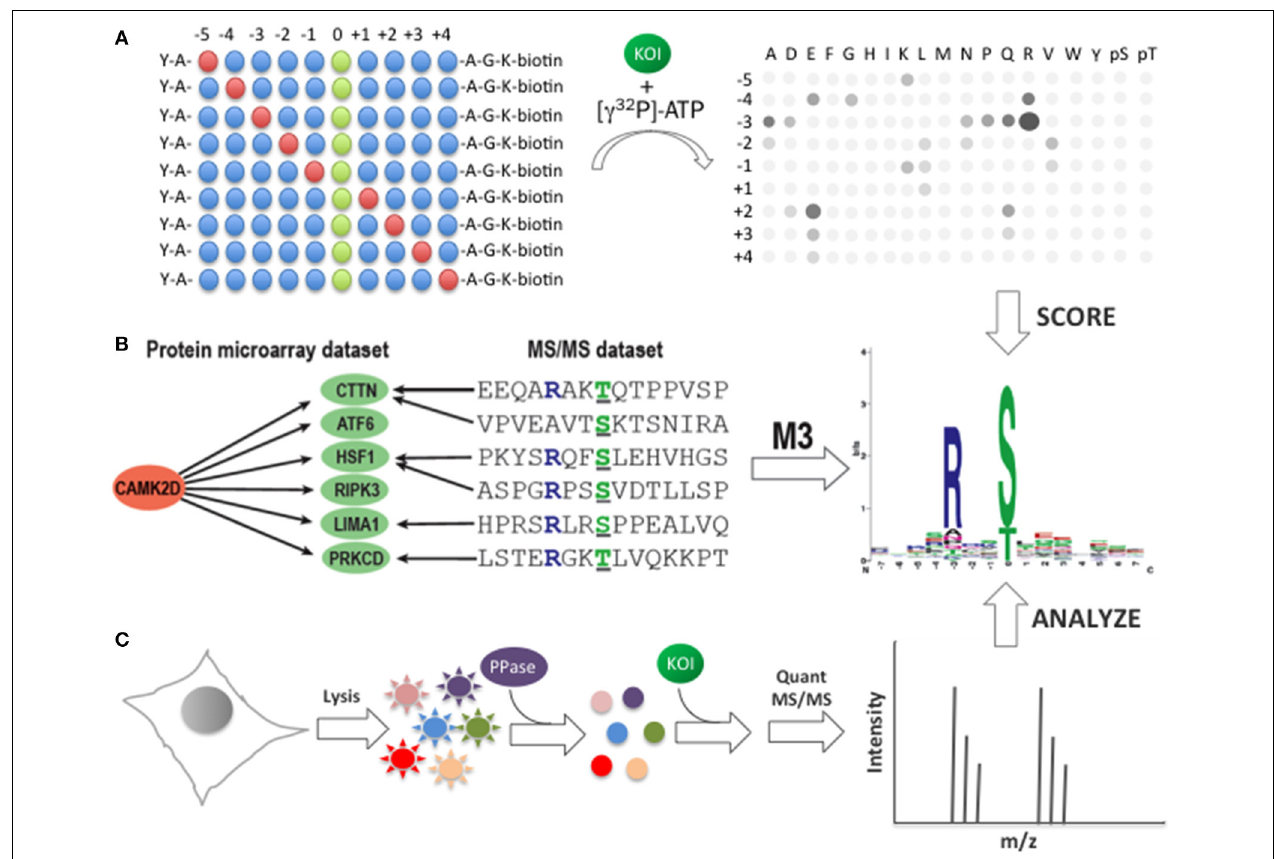
FIGURE 3 | Identification of consensus phosphorylation motifs. (A) Determination of phosphorylation motifs using scanning peptide arrays. A library of biotinylated peptides is first synthesized in which one position is fixed (red circles) at a defined position relative to the phosphoacceptor site (green circles). The fixed position can be any of the 20 canonical amino acids, as well as pThr or pTyr. All other positions in the peptide mixture contain equimolar amounts of the canonical amino acids, excluding Ser, Thr, and Cys (blue circles). To determine the consensus motif, each peptide mixture is incubated with the kinase-of-interest (KOI) in the presence of [ γ 32 P]-ATP before being immobilized on a streptavidin-coated membrane (right). The membrane is then washed, dried, and imaged. The resulting autoradiogram can be used to determine a consensus phosphorylation motif for the KOI